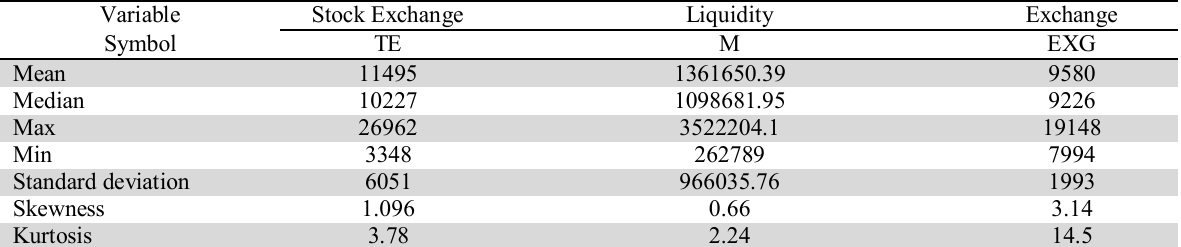
The summary of some basic statistics